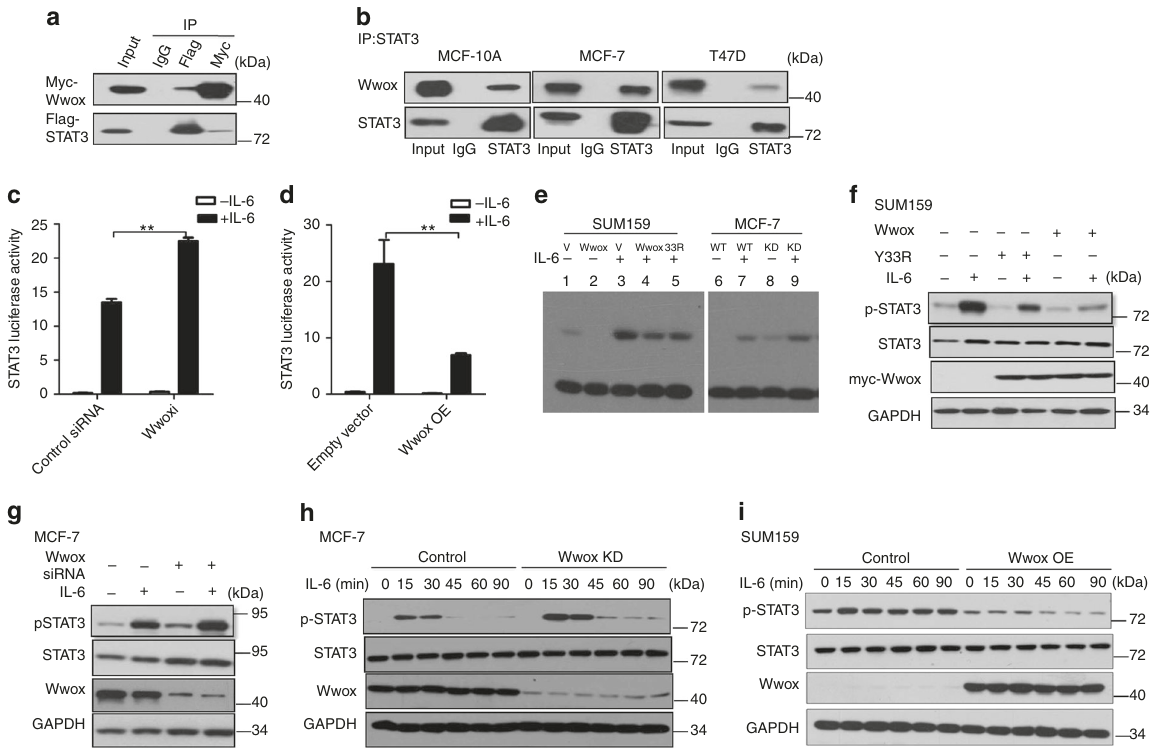
Fig. 3 Wwox inhibits STAT3 phosphorylation. a Co-immunoprecipitation of Wwox and STAT3 shows Wwox – STAT3 interaction in vivo. 293T cells were transfected with plasmids expressing Myc-tagged full-length Wwox or Flag-tagged full-length STAT3, as indicated. Whole-cell lysates were used in immunoprecipitation (IP) with anti-Myc antibody or anti-Flag M2 antibody. b Endogenous Wwox and STAT3 interact in vivo. Lysates of MCF-10A, MCF-7, and T47D cells were subjected to IP with anti-STAT3 antibodies. c , d Wwox inhibits STAT3 transcriptional activity. MCF-7 cells were co-transfected with APRE-luciferase reporter and Renilla luciferase reporter, in backgrounds providing depletion (via RNAi) of Wwox (Wwoxi) ( c ) or overexpression of Wwox (Wwox). d Relative luciferase activity data are presented as mean ± SD from three independent experiments; ** p < 0.01. e – g Wwox decreases the DNA- binding ability of STAT3. EMSA assays were performed using a biotin-labeled high-af fi nity binding site for STAT3. SUM159 cells were transfected